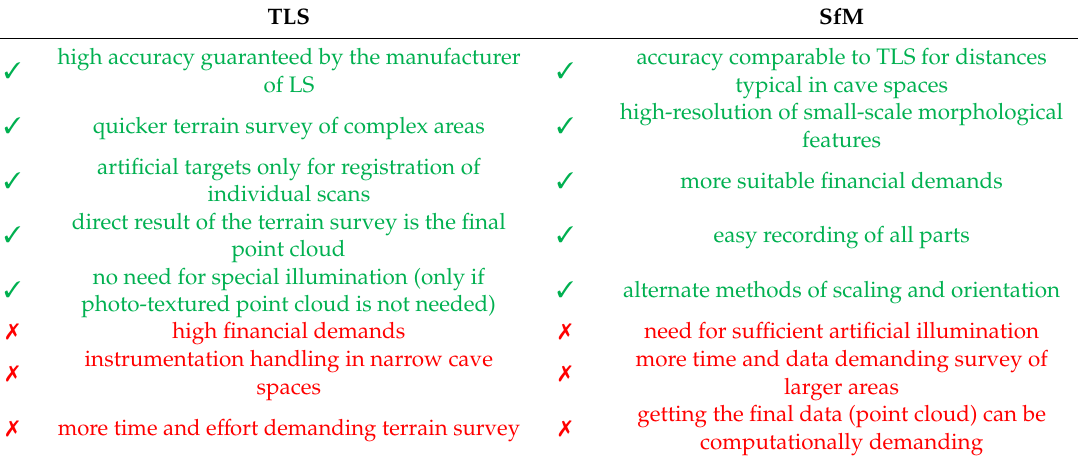
Table 2. A general comparison between Terrestrial Laser Scanning (TLS) and Structure-from-Motion (SfM).